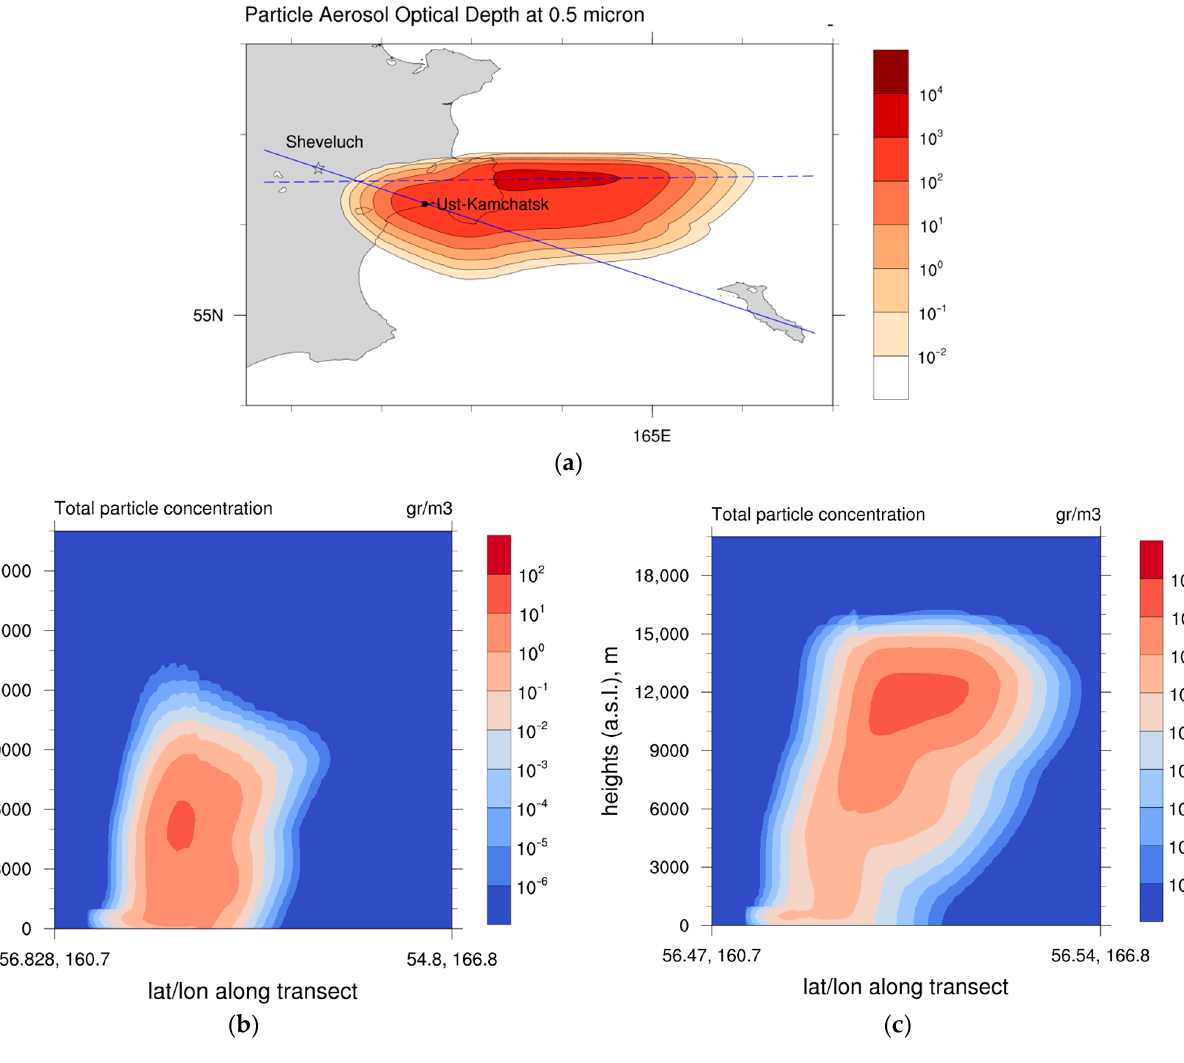
Figure 8. The visualization of the modeling results for the Sheveluch eruptive cloud as of 21:37 UTC, 11 November 1964: ( a ) The optical density of the aerosol; ( b ) Ash concentration: cross-section along the solid line in ( a ); ( c ) Ash concentration: cross-section along the dashed line in ( a ).